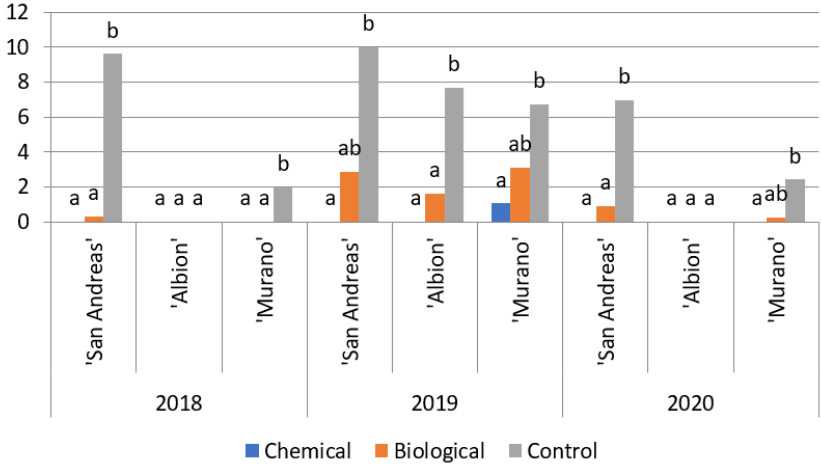
Figure 3. Percentage of fruit infected by fungi of the genus Colletotrichum among fruit waste at harvest [%]. Bars on which the same letter follows within a cultivar for each year are not significantly different at p ≤ 0.05.